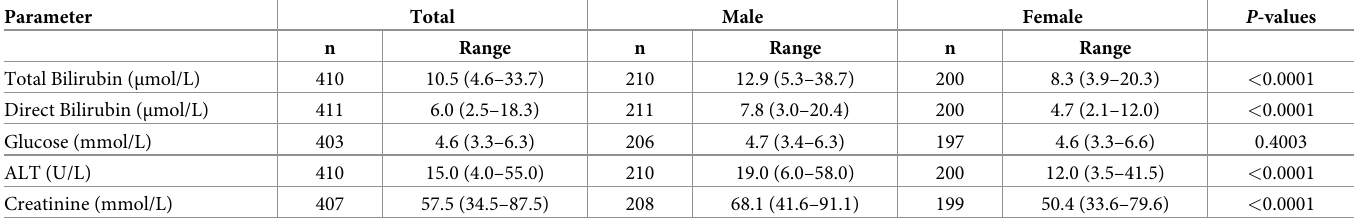
Table 5. Clinical chemistry reference ranges (median and 2.5 th - 97.5 th percentiles) derived from healthy adults at high-risk for HIV in Mozambique.